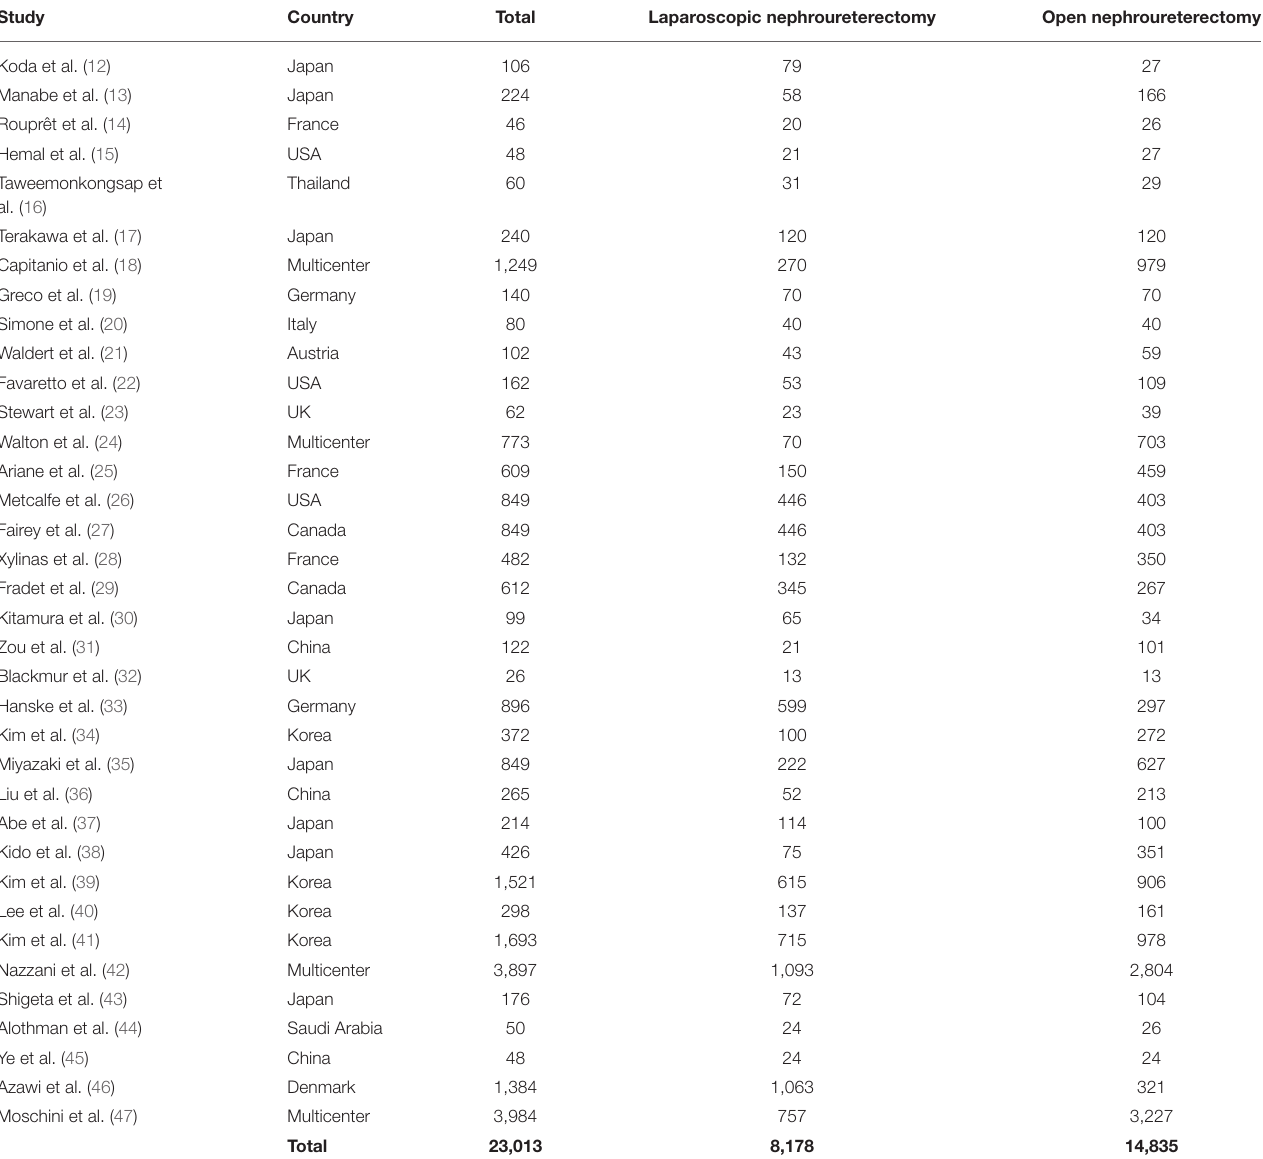
TABLE 2 | Characteristics of the selected studies for the